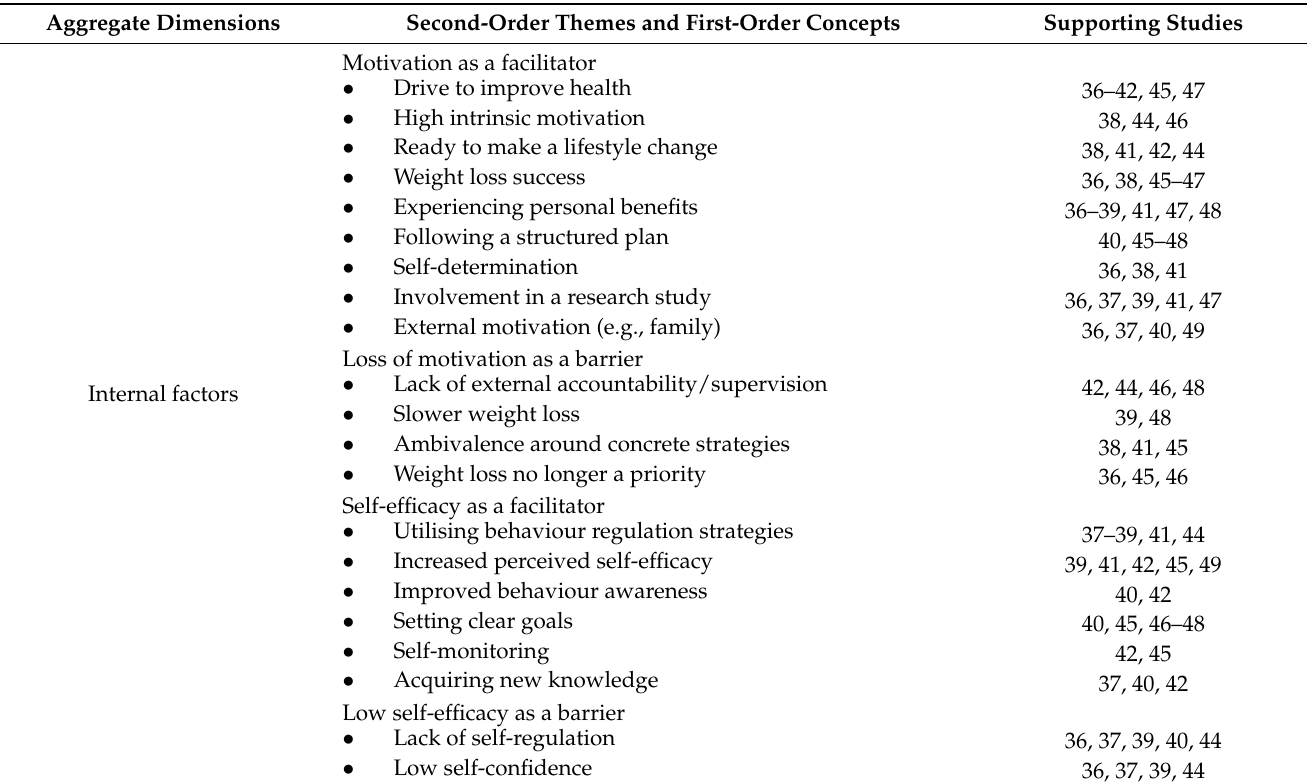
Table 3. Summary of themes derived from the studies